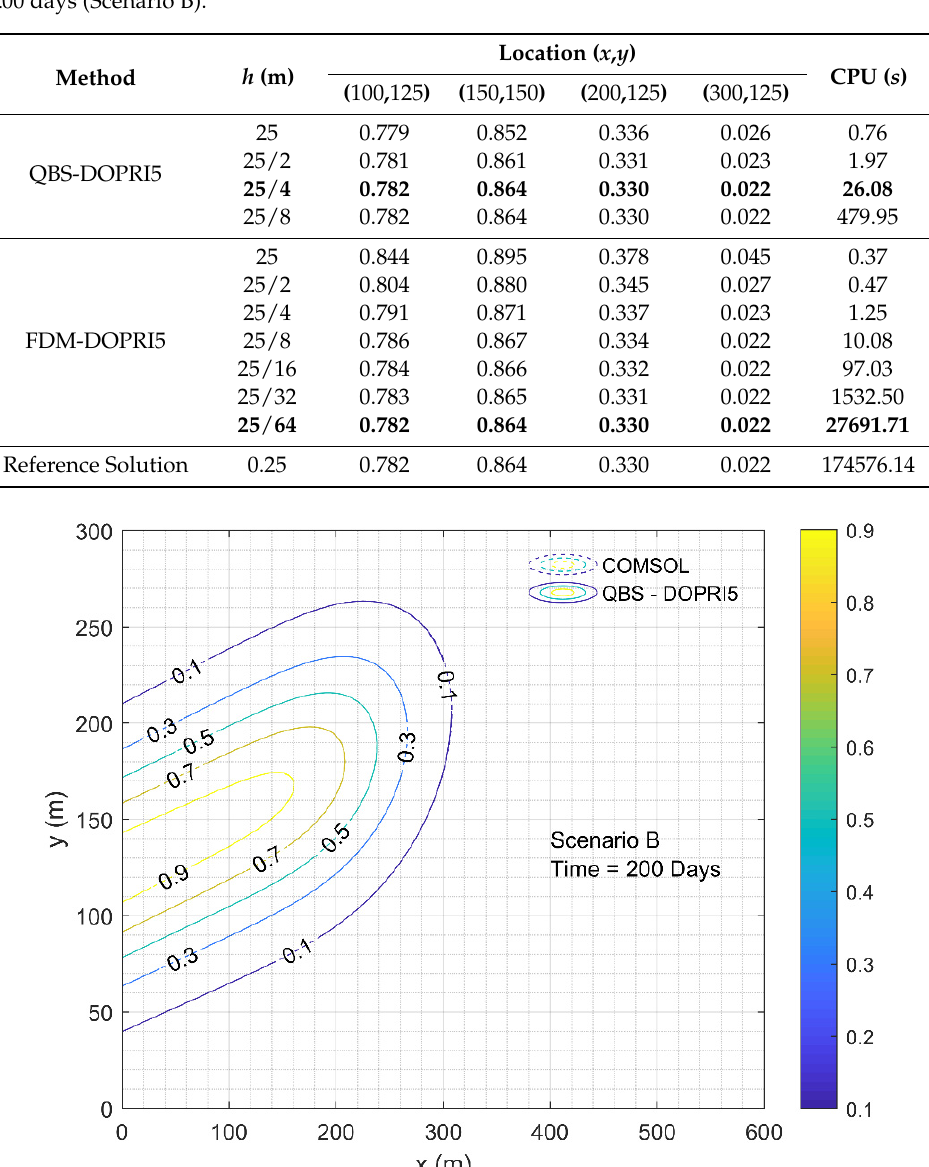
Figure 7. Comparison of approximate solutions obtained by QBS-DOPRI5 ( ∆ x = ∆ y = 5 m ) and COMSOL Multiphysics.